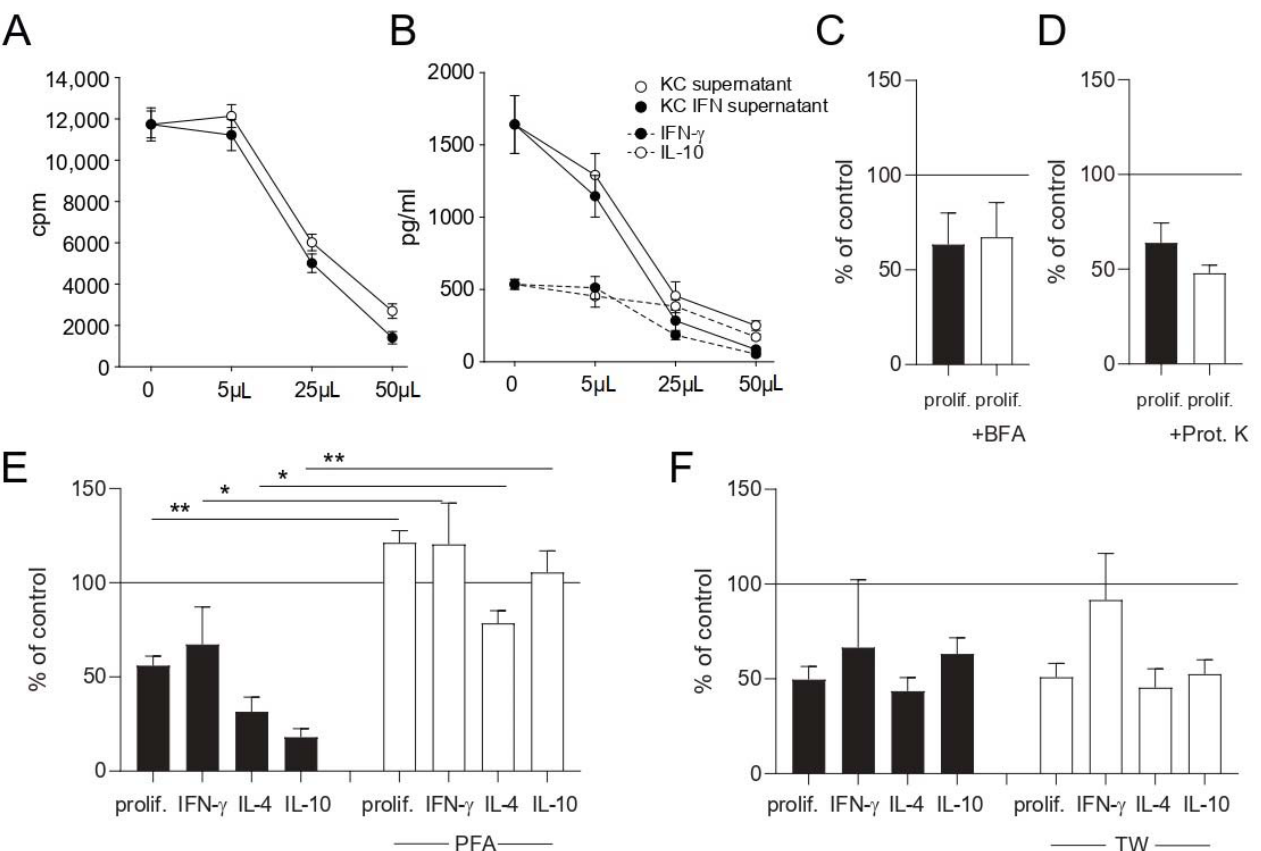
Figure 5. Keratinocytes inhibit T cell effector functions through the production of soluble factor/s. Cell-free culture supernatants of keratinocyte- or IFN- γ -prestimulated keratinocyte cultures (KC IFN) were obtained and used in different volumes in co-culture experiments. Proliferation ( A ) and cytokine production ( B ) were measured after 48 h by 3H-thymidine incorporation and ELISA of co-culture supernatants, respectively. Unstimulated keratinocytes were fixed with PFA ( E ) or treated with brefeldin A (BFA) to block the Golgi apparatus ( C ) prior to co-culture with nickel-specific T cell clones and dendritic cells. Supernatants of unstimulated keratinocytes were treated for 30 min with proteinase K (Prot. K) ( D ) prior to co-culture with nickel-specific T cell clones and dendritic cells. Keratinocytes were separated from nickel-specific T cells and dendritic cells via a transwell chamber (TW) ( F ). To rule out any effects from the keratinocyte medium, the medium was added to every control stimulation in the same volume as was used for the keratinocyte supernatant experiments. (( A ) results of one representative nickel-specific Th1 clone; ( E ) clones = 8, n = 16; ( C , D ) clones = 4, n = 8; ( F ) clones = 5, n = 14; *: p < 0.05; **: p <